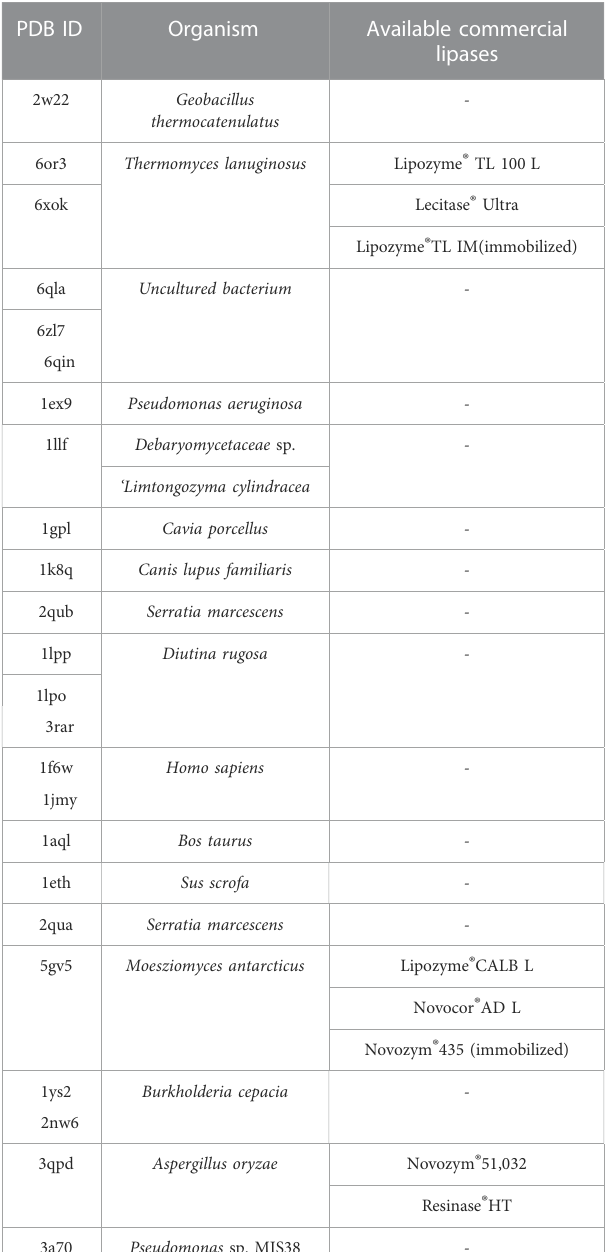
TABLE 2 The screened structures with betterperformances in both af fi nity and distance and their